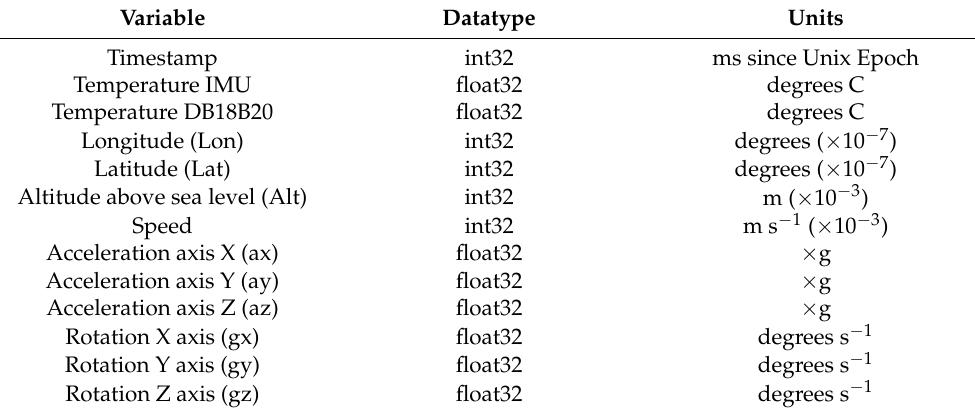
Table 1. Raw data collected by the sensorized collar and saved in the microSD